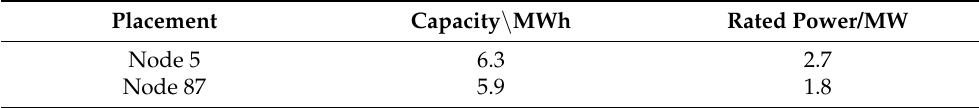
Table 14. Results of the planning variant